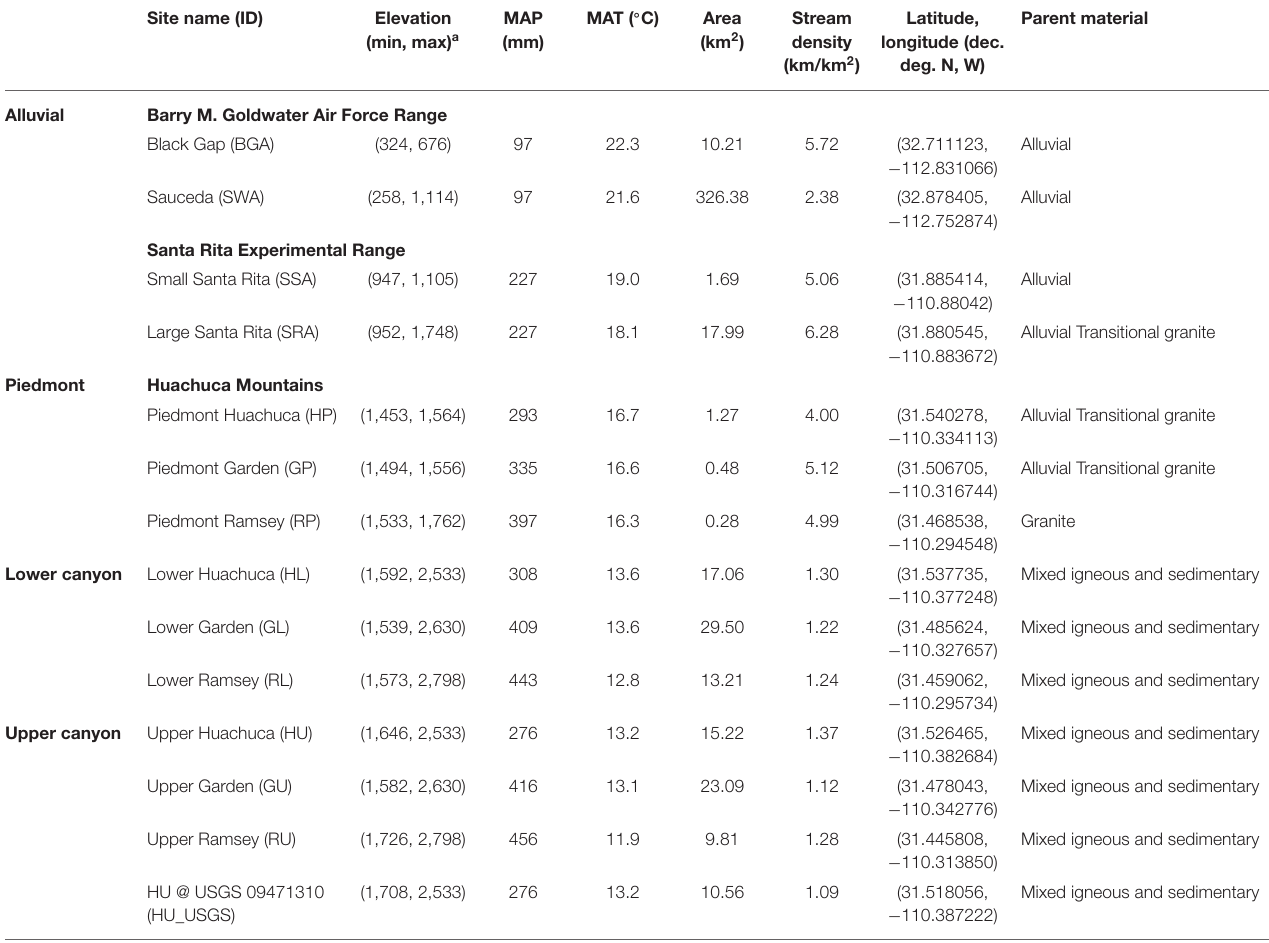
TABLE 1 | Catchment characteristics including elevation, mean annual precipitation (MAP), and temperature (MAT) from PRISM Climate Group (2013), area, stream density, latitude and longitude in decimal degrees, and parent